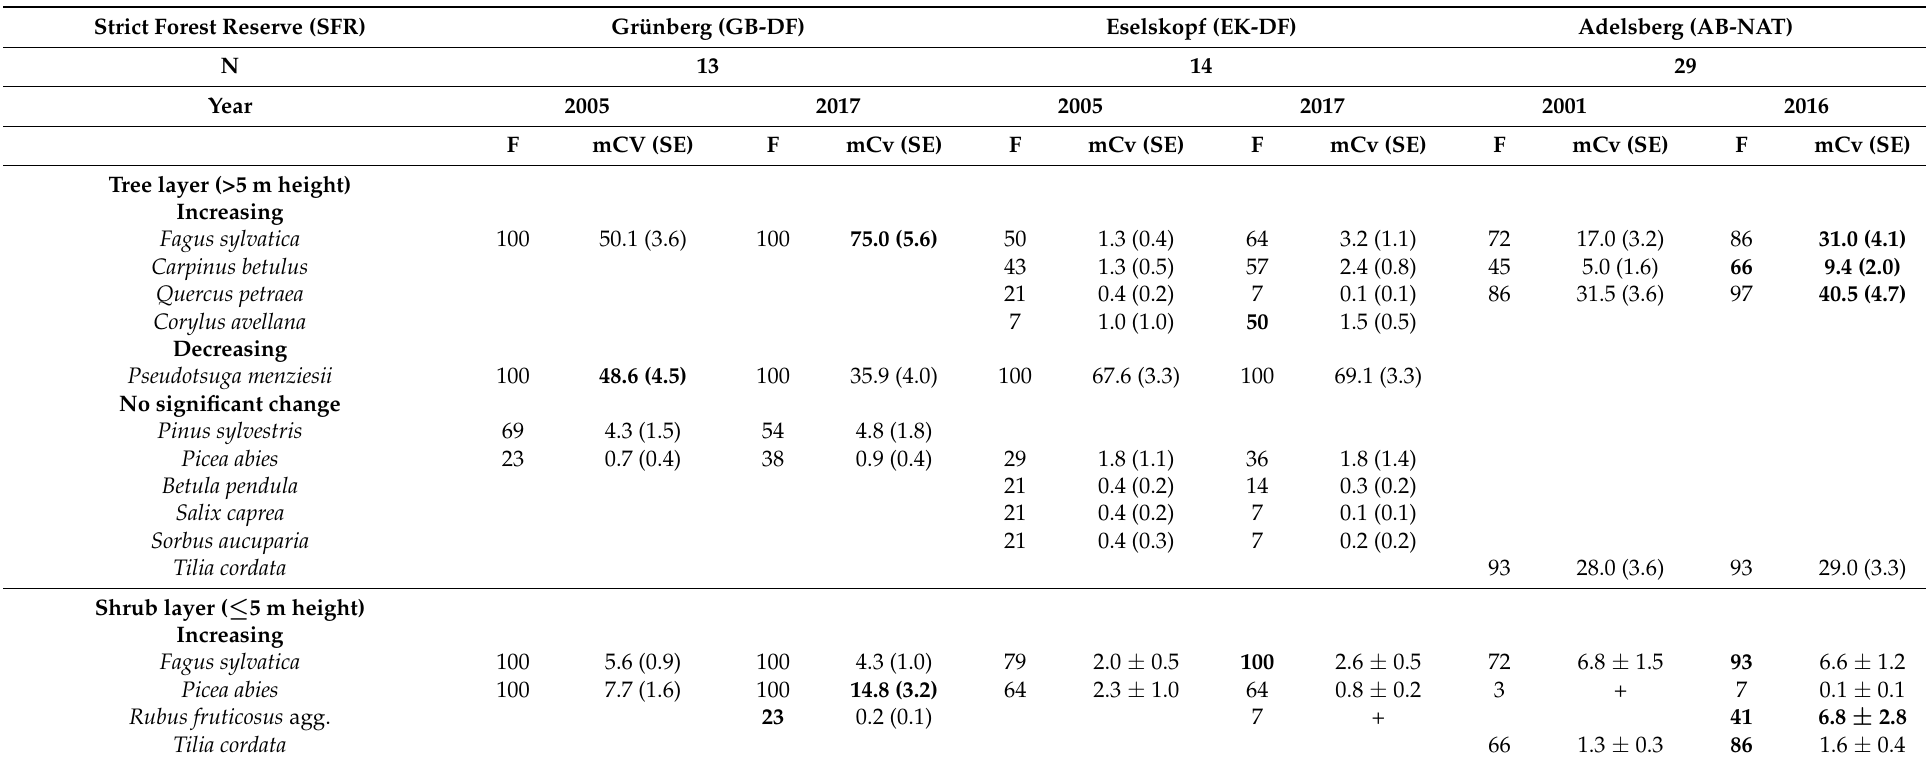
Table 4. Frequency of occurrence (F) and mean cover values in % with standard error (mCV (SE)) for all woody species surveyed in the 400 m 2 subplots in the core areas of the three strict forest reserves (SFR) Grünberg, Eselskopf (both characterized by Douglas fir (DF) and Adelsberg (dominated by native tree species (NAT)) for the two surveys. Species were grouped into the tree layer, shrub layer and herb layer and were ordered according to their temporal dynamics. Significant higher cover values between surveys according to the Wilcoxon signed rank test and higher frequency values of at least 20% comparing both surveys are written in bold, +: